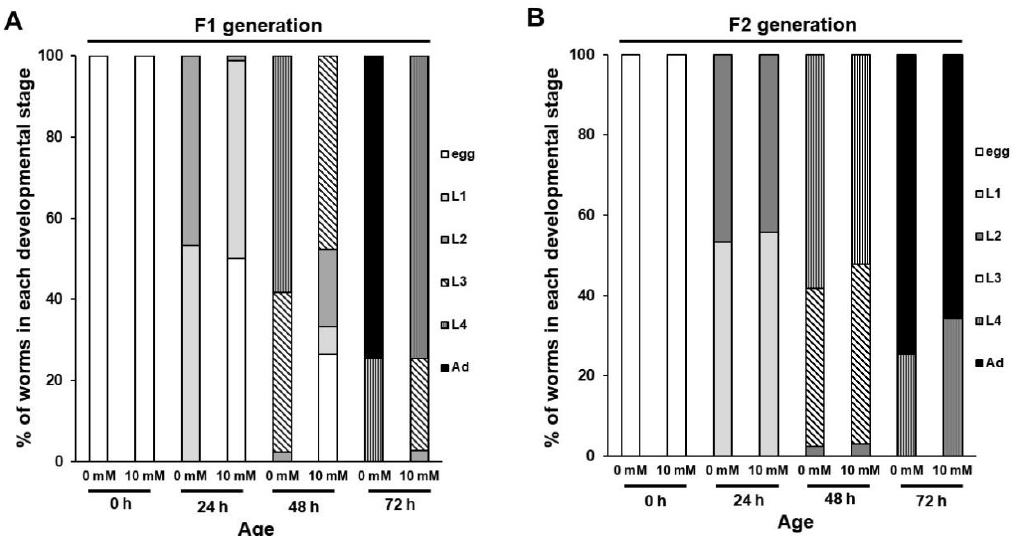
Figure 3. Caffeine intake by P0 mothers affected development in the subsequent generation of Caenorhabditis elegans . ( A , B ) Synchronized L4-stage animals ( n = 30) of C. elegans wild-type were fed either 0 or 10 mM of caffeine for 24 h, and embryos were transferred to respective OP50-seeded nematode growth medium plates and further cultured at 20 °C. The developmental stage of each individual in the F1 and F2 generations was determined based on its size and stage-specific morphological characteristics (see Section 2 for details) during development by either caffeine-ingested (10 mM) or caffeine-free diet P0 mother (0 mM).